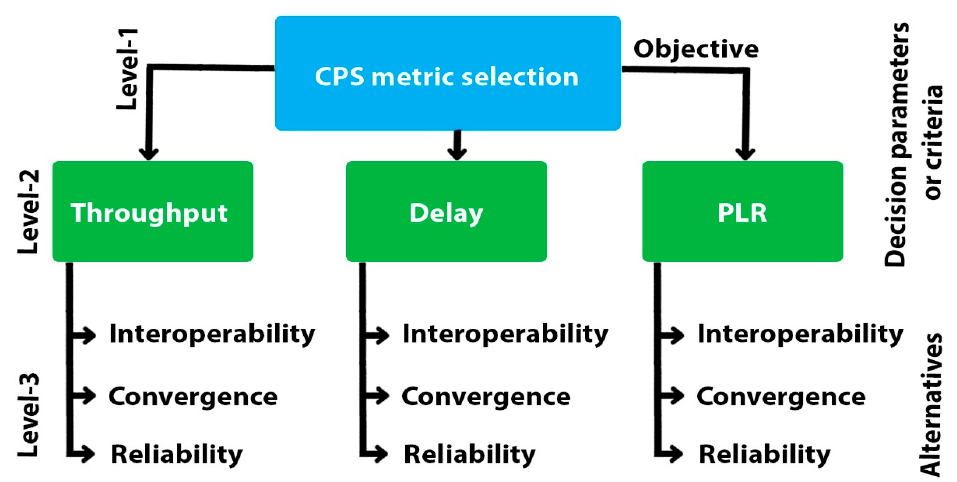
Figure 4. Proposed joint convergent, interoperable, and reliable healthcare: ( a ) block diagram, ( b ) 6G framework.